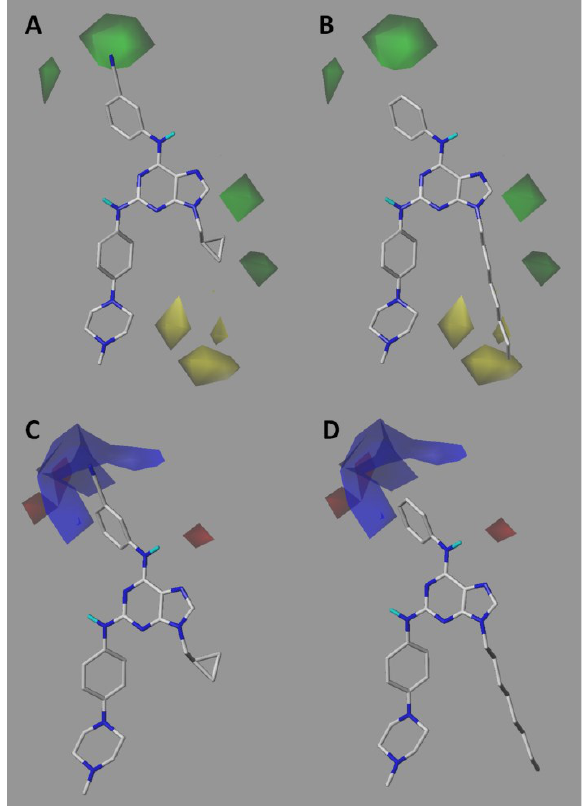
Figure 5. Steric ( A , B ) and electrostatic ( C , D ) contour maps in Bcr-Abl. The most active compound 4f ( A , C ) is compared against the least active 5j ( B , D ).